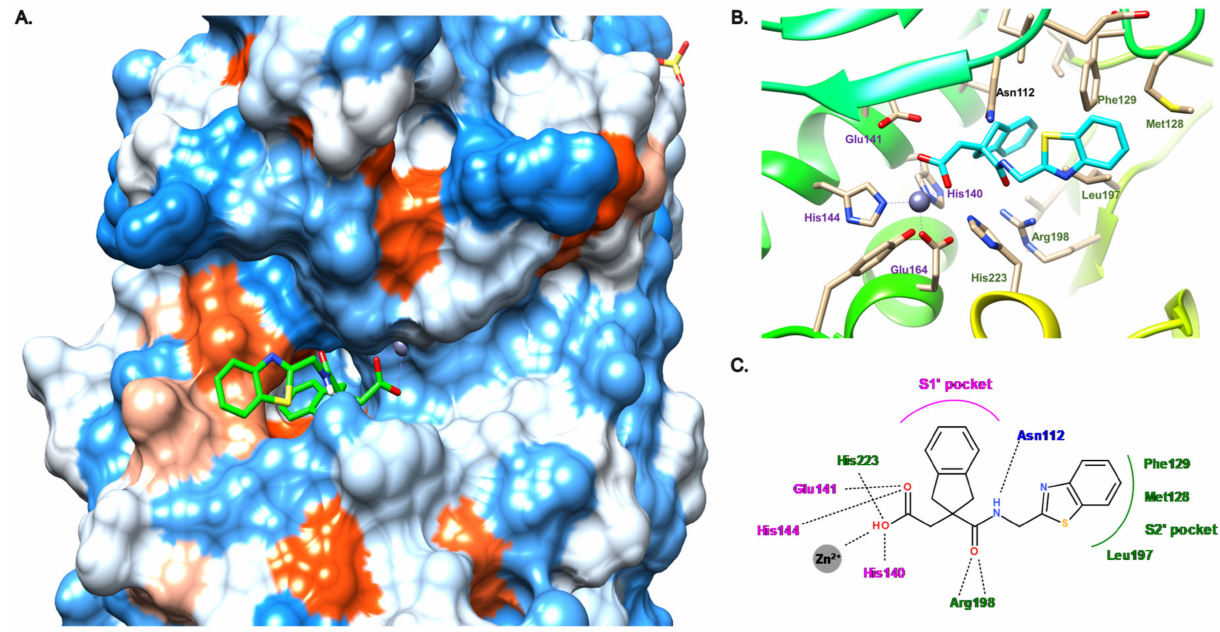
Figure 12. Binding mode of 19 from PDB entry 7AJR [47]. ( A ) View of the active site of LasB, in surface mode, accommodating 19 (green) visualized using Chimera 1.15. The zinc cation is represented as a gray sphere. ( B ) View of the active site of LasB with 19 (blue) and key residues (gray sticks) involved in the binding visualized using Chimera 1.15. ( C ) Two-dimensional schematic representation of the binding mode of 19 . The key interactions are indicated as dashes, the zinc cation is represented as a gray sphere, and the key residues are indicated in pink for those belonging to the S1 (cid:48) pocket, green for those belonging to the S2 (cid:48) pocket and blue for the